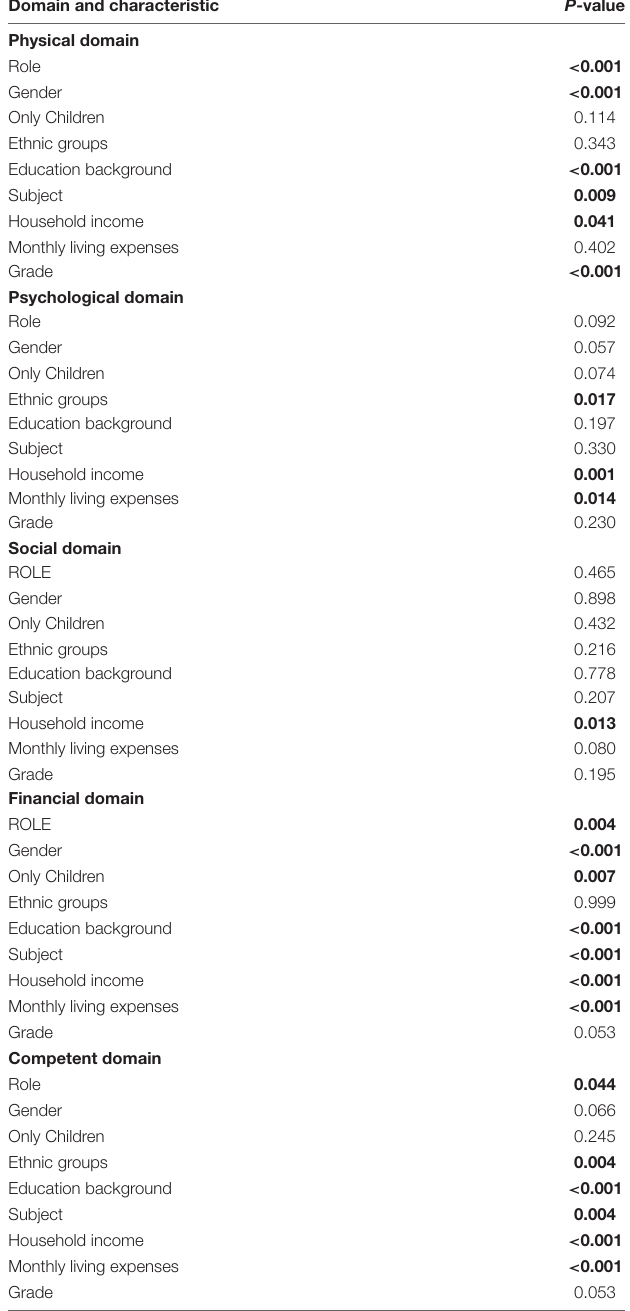
TABLE 11 | Effect of socio-demographic variables on well-being in each domain ( N = 1870). Domain and characteristic P